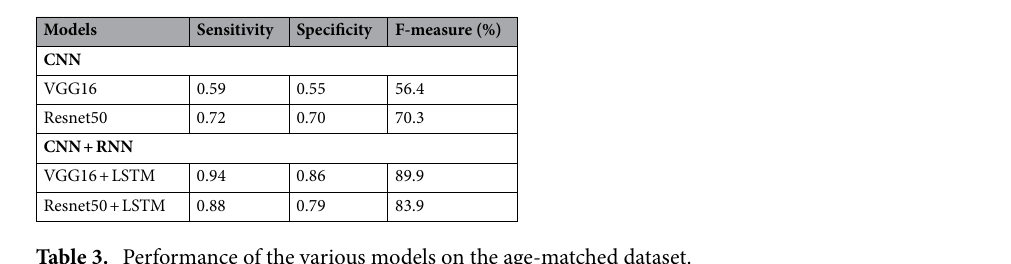
Table 3. Performance of the various models on the age-matched dataset.